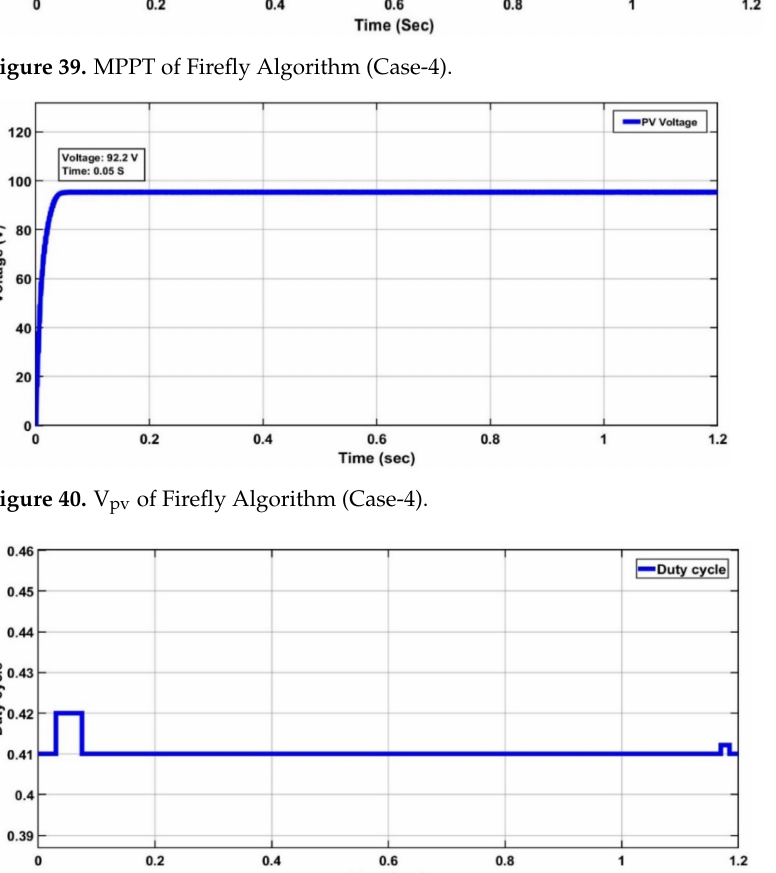
Figure 41. Duty cycle of Firefly Algorithm